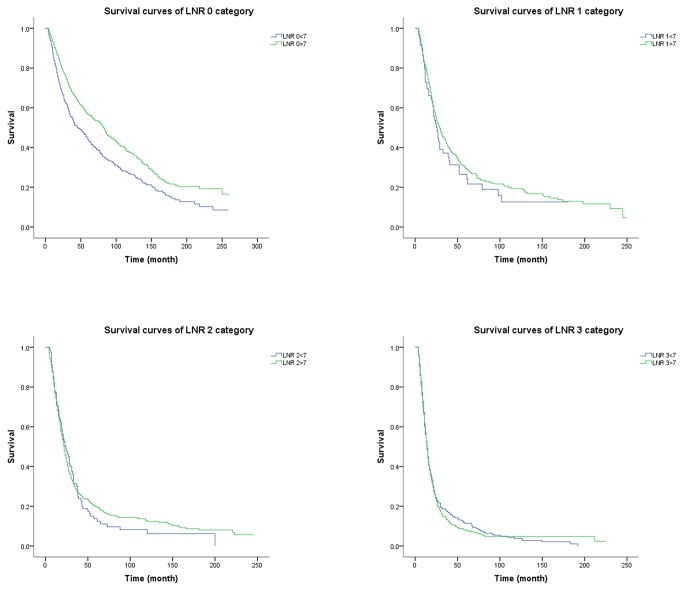
Overall survival according to LNR categories, stratified by the number of examined lymph nodes.